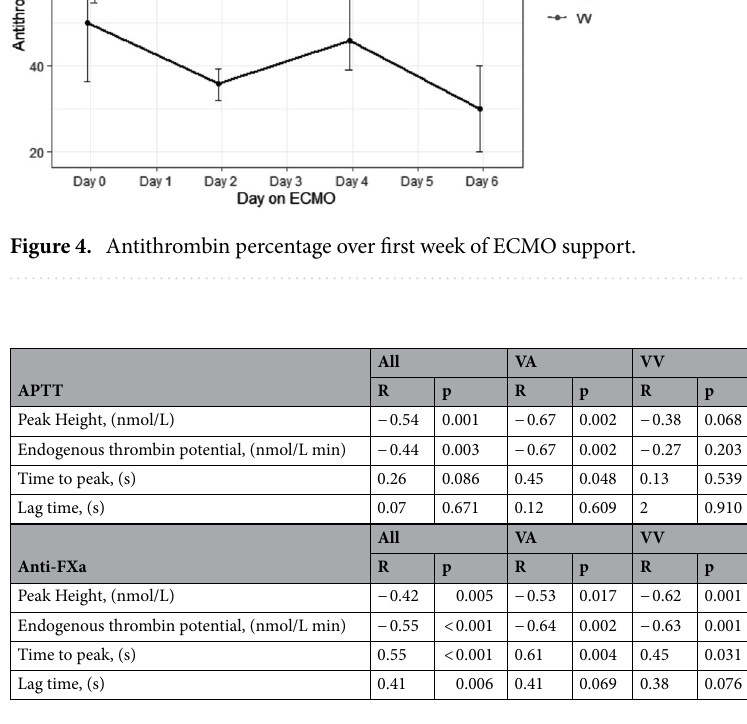
Table 3. APTT and Anti-FXa correlation to markers of thrombin generation. s = seconds.